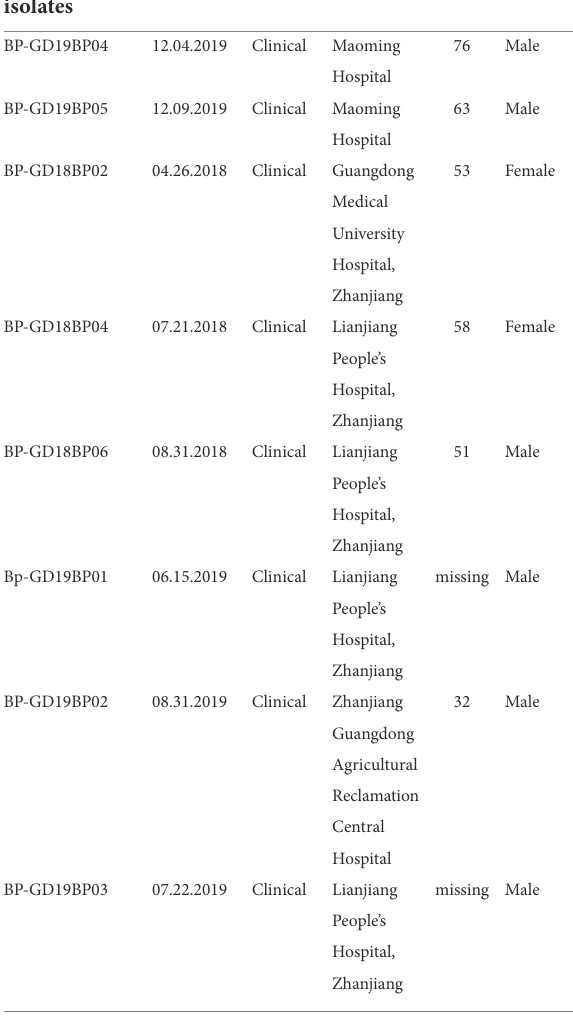
TABLE 1 Number of B. pseudomallei strains recovered from Guangdong during 2018–19. B.